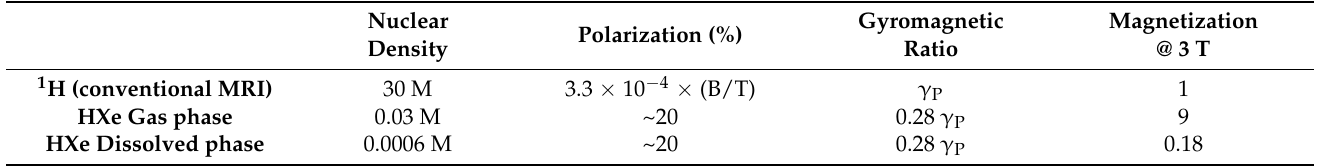
Table 2. Relative 1 H and HXe magnetization available for MRI. γ P refers to the gyromagnetic ratio of the proton. These approximations assume that 80% of alveolar gas is replaced with 85% 129 Xe-enriched HXe. Gyromagnetic Magnetization Nuclear Polarization (%) Ratio @ 3 Density